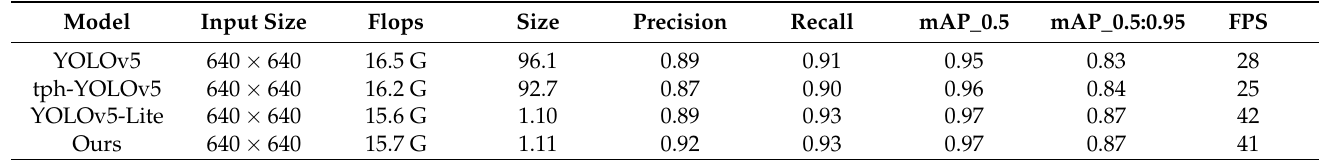
Table 1. Comparison of detection results with other methods.